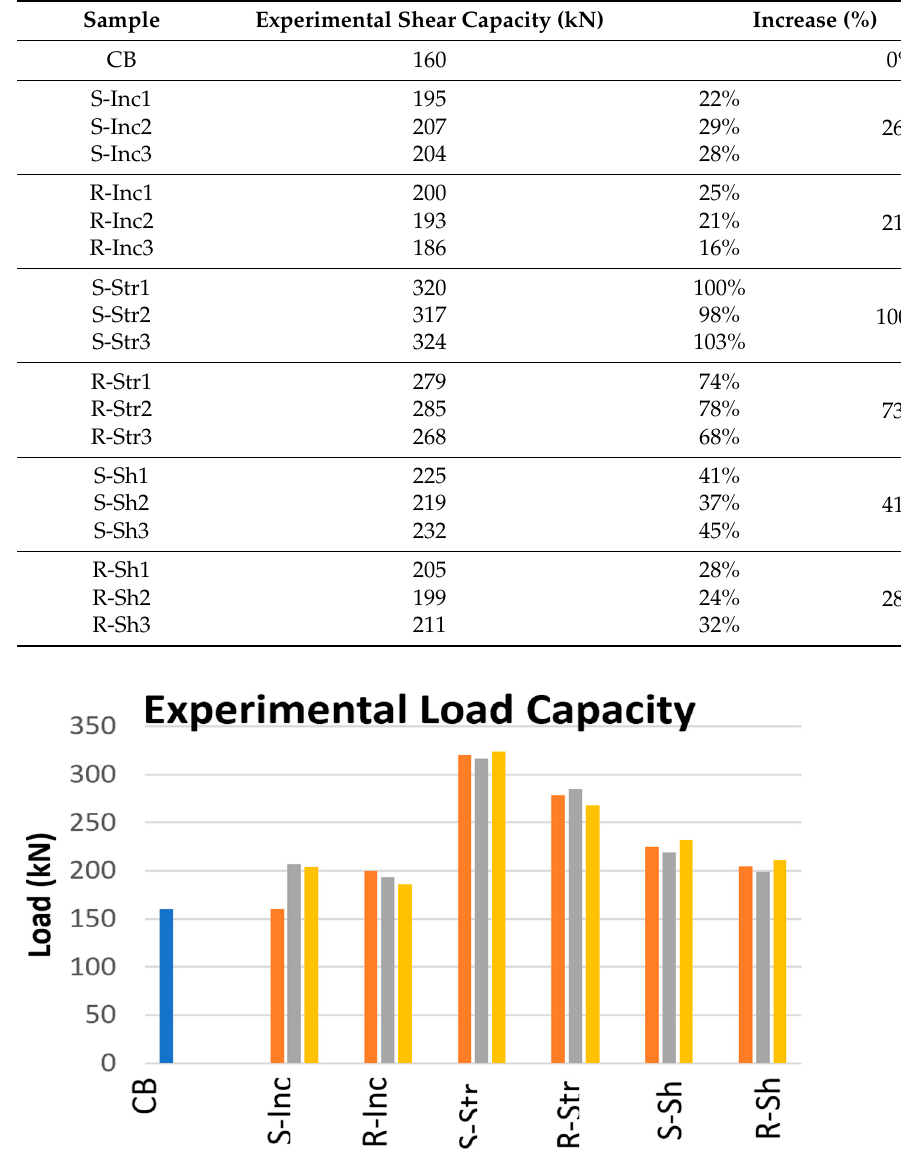
Figure 6. Comparison between the experimental shear capacities for all beams.